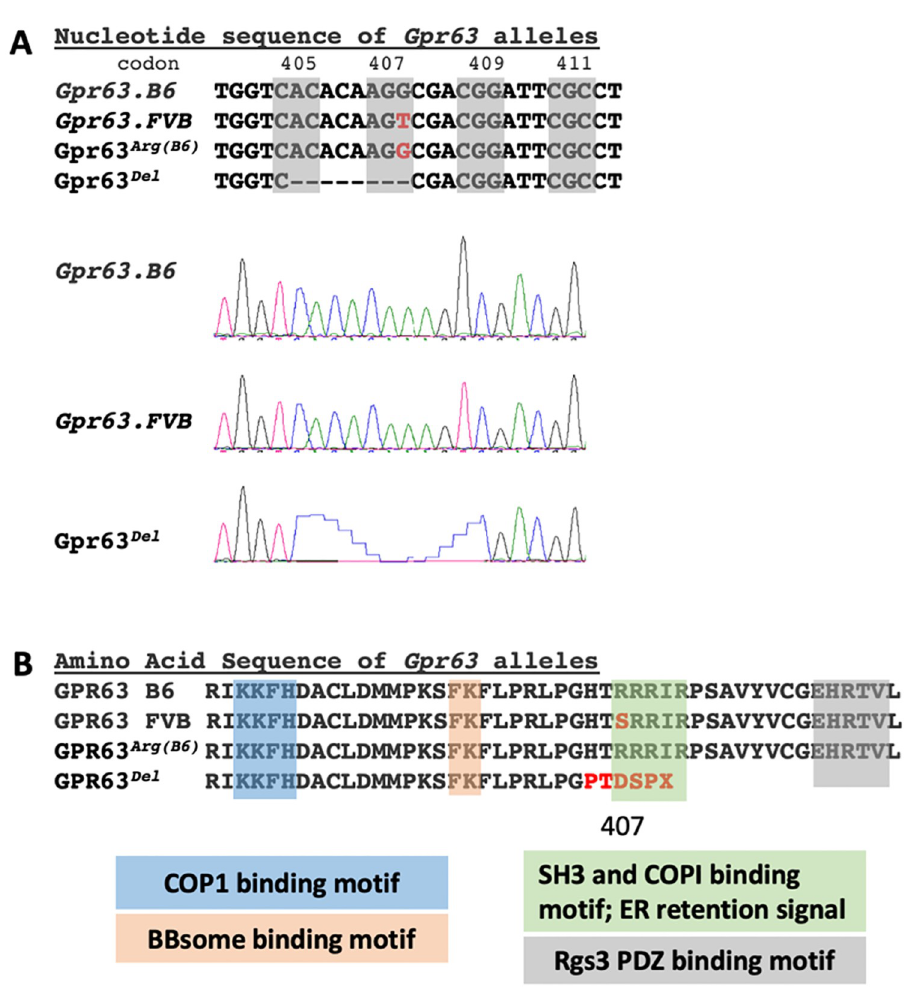
Fig 6. CRISPR-Cas9 alleles of Gpr63 . (A) Nucleotide sequence and Sanger sequencing of Gpr63 in the B6/reference strain and FVB strain with the c.G1635T SNP. Gpr63 Arg(B6) is the FVB mouse line with the B6 Thymidine at Gpr63 c.1635. Gpr63 Del is an 8-bp deletion in the same region of Gpr63 . (B) Amino acid sequence of the above lines showing the R407S polymorphism between B6 (Arg) and FVB (Ser) reverted to B6 (Arg) in the CRISPR transgenic, and the missense mutation and premature truncation in the Gpr63 Del allele.